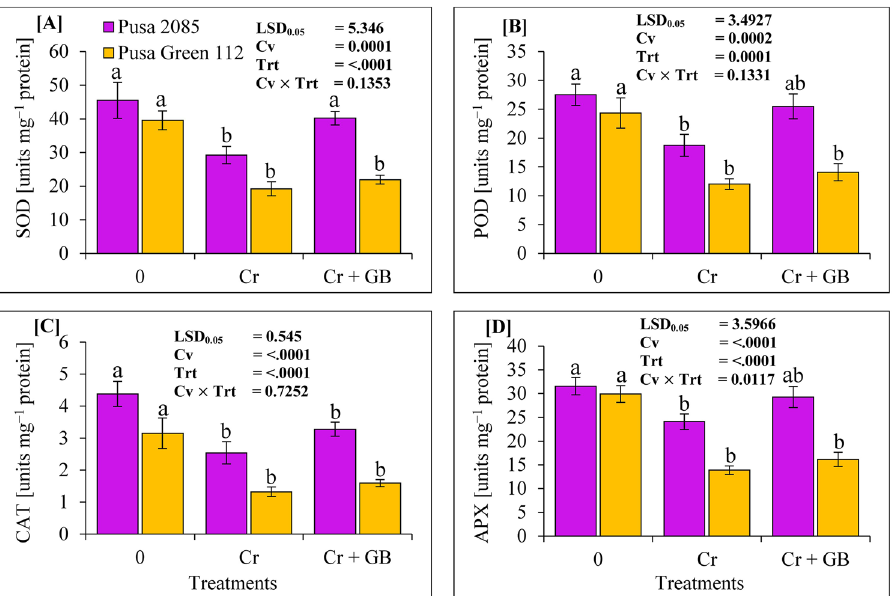
Figure 6. Effects of different stress levels of Glycine Betaine (GB) and Chromium (Cr), 0 and 120 μM Cr and 120 μM Cr + 100 mM (GB), on the enzymatic activities of ( A ) superoxide dismutase (SOD), ( B ) peroxidase (POD), ( C ) catalase (CAT), and ( D ) ascorbate peroxidase (APX) (units mg −1 protein) in the leaves of the chickpea cultivars, Pusa 2085 and Pusa Green 112, at 42 days after sowing (grown in pots). Generated data values are shown as the mean of five replicates ± SE. The error bars indicated by the different letters represent significant differences, as tested by the least significant difference test (p <